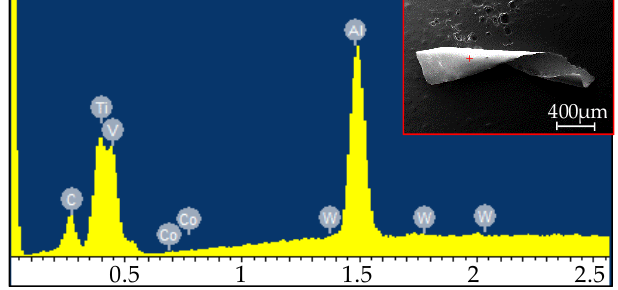
Figure 12. EDS analysis of the chip.